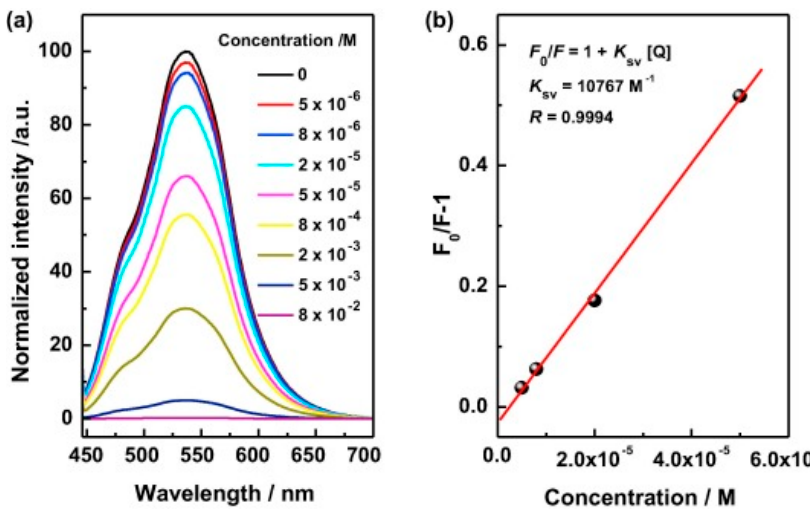
Figure 21. ( a ) Study of fluorescence emission quenching of PAC/ethanol dispersion at different nitrobenzene / ethanol solutions; ( b ) Stern-Volmer plot between F / F 0 and nitrobenzene concentration. nitrobenzene/ethanol solutions; ( b ) Stern-Volmer plot between F/F 0 and nitrobenzene concentration. Reproduced with permission from [172]. Copyright (2019) Reproduced with permission from [172]. Copyright (2019) Elsevier.